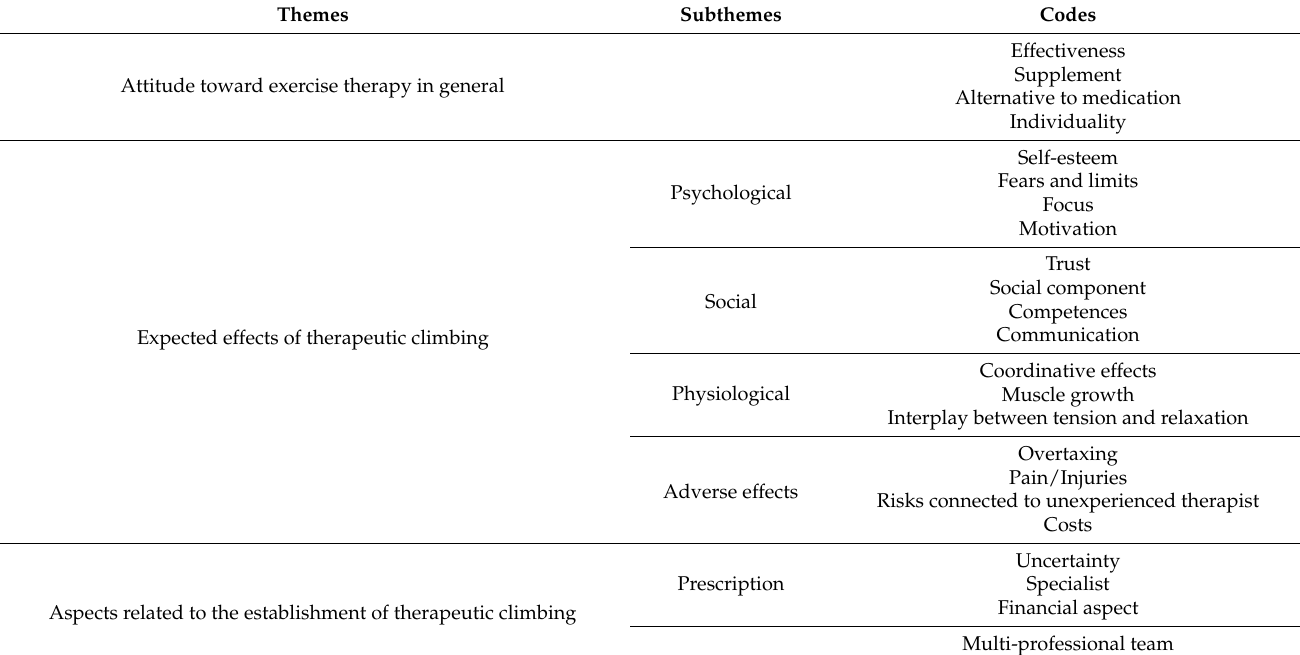
Table 2. Themes, subthemes, and